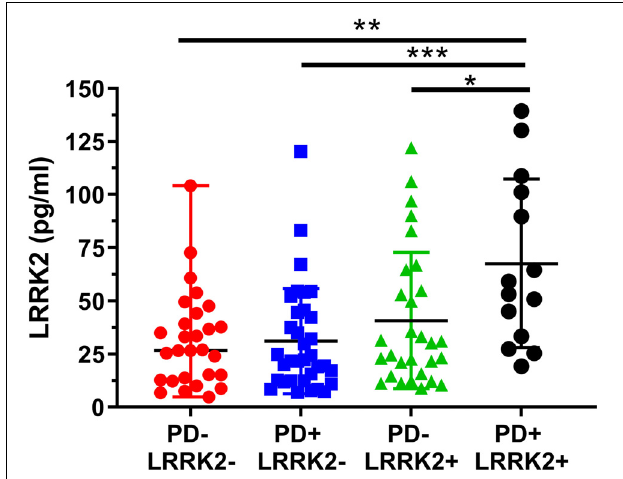
FIGURE 6 | Analysis of mean CSF LRRK2 levels in the LRRK2 Cohort Consortium samples shows that LRRK2 was significantly higher in the PD+ LRRK2+ group compared to all other groups. No other groups were significantly different from each other. ∗ p < 0.05, ∗∗ p < 0.01, ∗∗∗ p < 0.001.